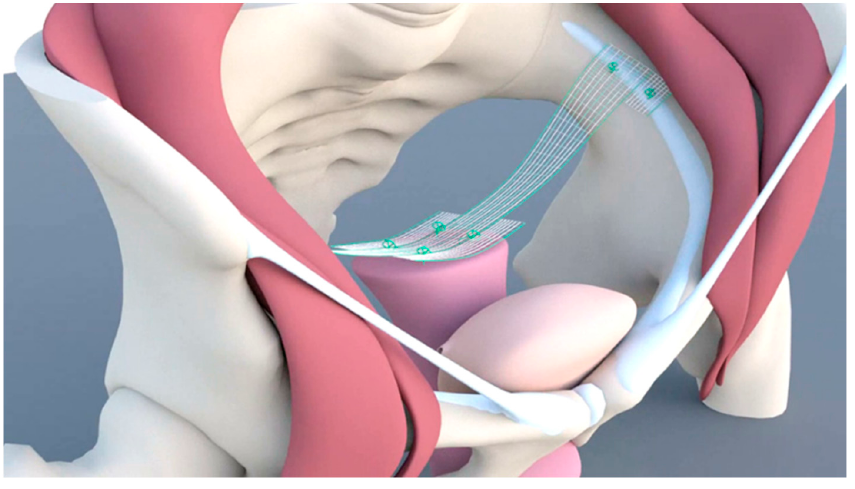
Figure 4. Mesh placement in pectopexy